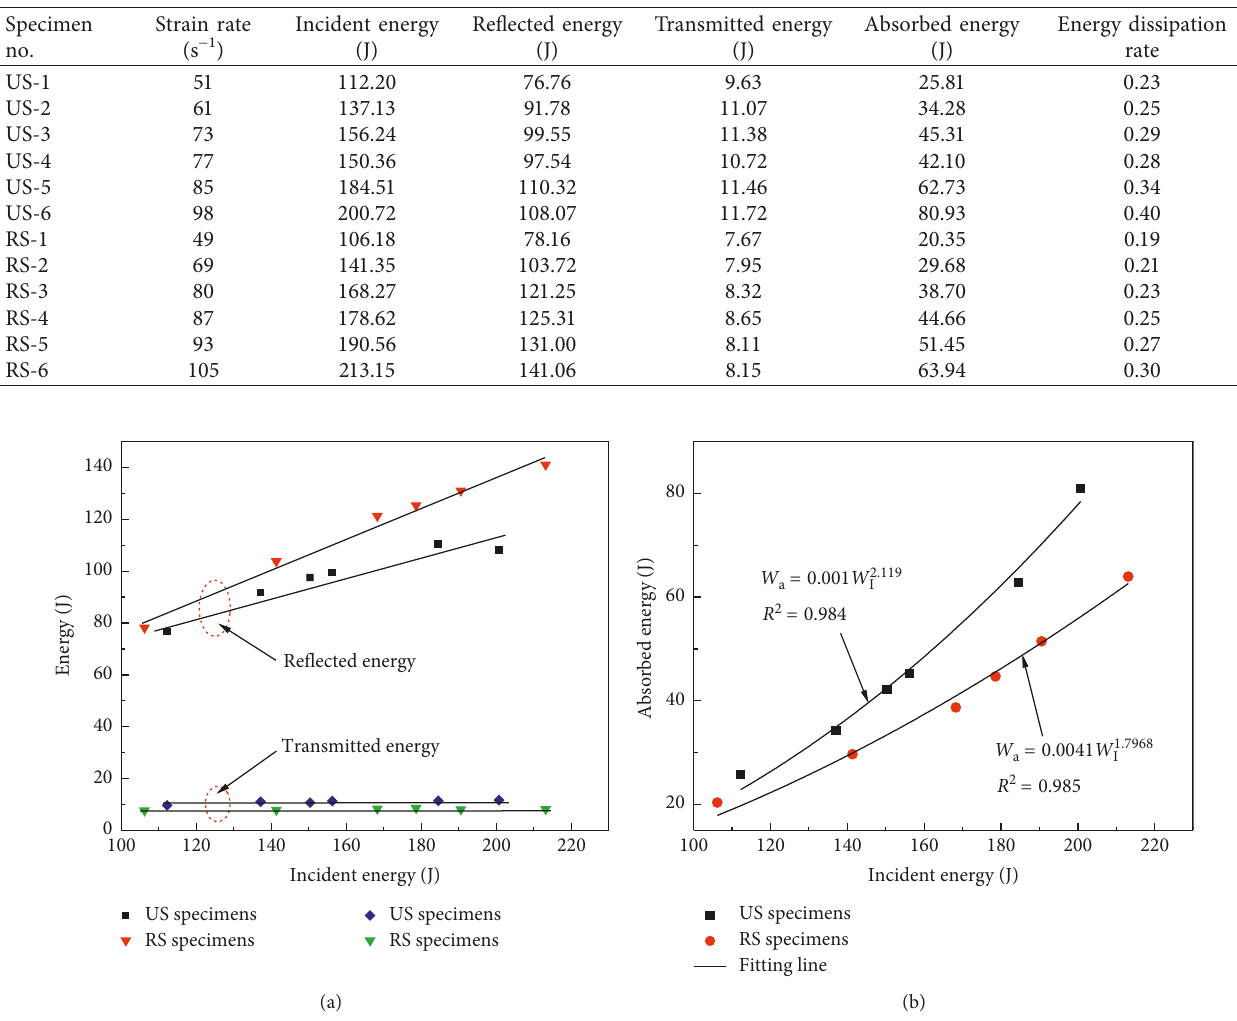
Figure 10: Relation between energy and incident energy. (a) The reflected and transmitted energy of specimens. (b) The absorbed energy of